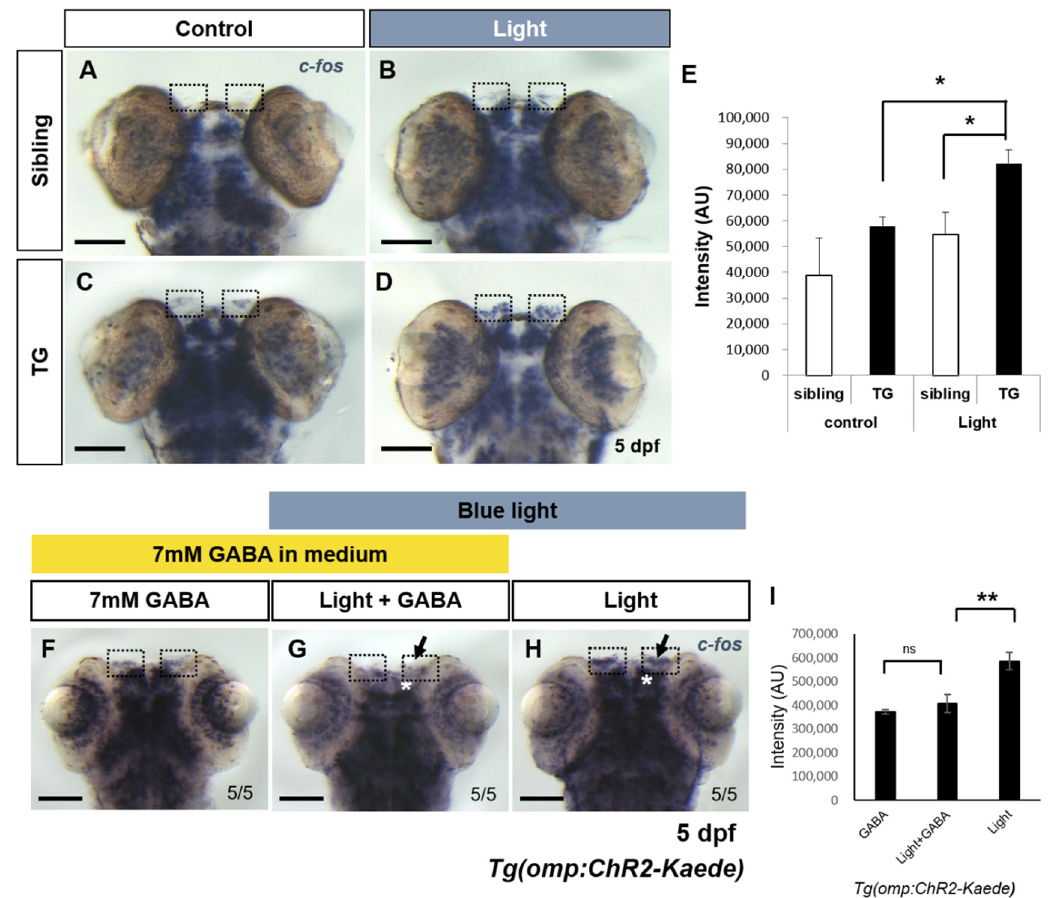
Figure 2. Expression analysis of c-fos for evaluating light-induced neuronal activity in transgenic fish. ( A – D ) Whole-mount in situ hybridization of c-fos in the transgenic fish and non-transgenic siblings at 5 dpf. ( A ) Control non-transgenic fish. ( B ) Light-irradiated non-transgenic fish. ( C ) Control transgenic fish. ( D ) Light-irradiated transgenic fish. Dotted boxes indicate olfactory epithelium of 5 dpf zebrafish. In light-irradiated transgenic fish, c-fos expression was ectopically induced at the olfactory epithelium ( D ). ( E ) Quantitative analysis of c-fos expression in olfactory epithelium. Intensity of c-fos transcripts in olfactory epithelium (dotted boxes) was measured by Image J. n = 4 for control sibling; n = 4 for control TG; n = 4 for light-irradiated sibling; and n = 5 for light-irradiated TG. (Tg light vs. Tg control, p = 0.0095; Tg light vs. sibling light, p = 0.04181). ( F – H ) Suppression of light-evoked odor response by GABA application in transgenic fish expressing ChR2 in the olfactory sensory neurons. ( F ) 7mM GABA treated control transgenic zebrafish at 5 dpf. ( G ) Optically stimulated transgenic zebrafish with GABA. ( H ) Light-irradiated transgenic zebrafish. Black arrow indicates olfactory epithelium and asterisk marked olfactory bulb. ( I ) Intensity of c-fos expression in olfactory epithelium upon GABA treatment. n = 5 for each experiment. (Tg light vs. Tg light + GABA, p = 0.005). All values are represented as mean ± S.E.M; * p < 0.05 and ** p < 0.005. p value was determined by unpaired t test. ns, not significant. Scale bars: 100 μ m.